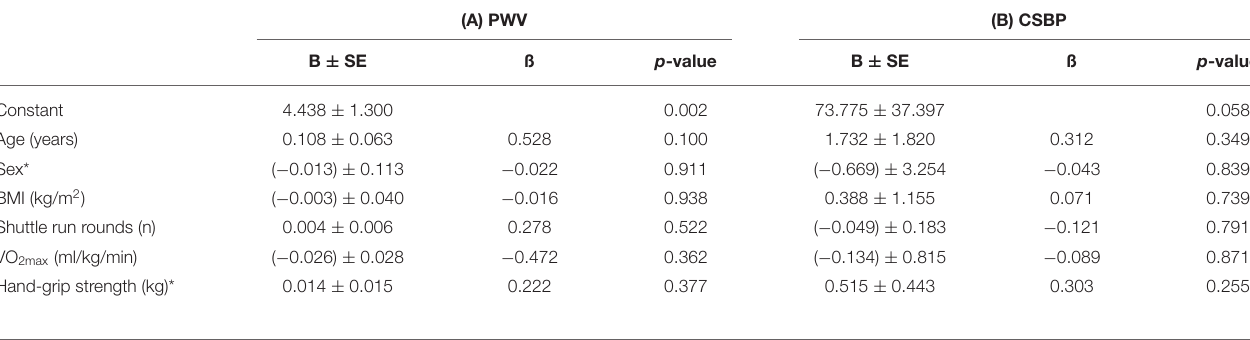
TABLE 6 | Multiple linear regression